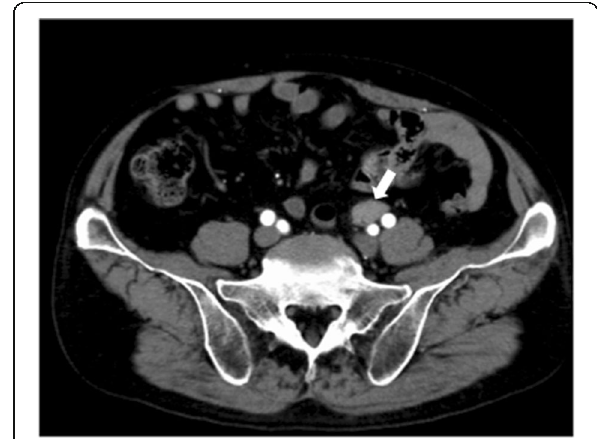
Fig. 1 Enhanced abdominal computed tomography (CT)